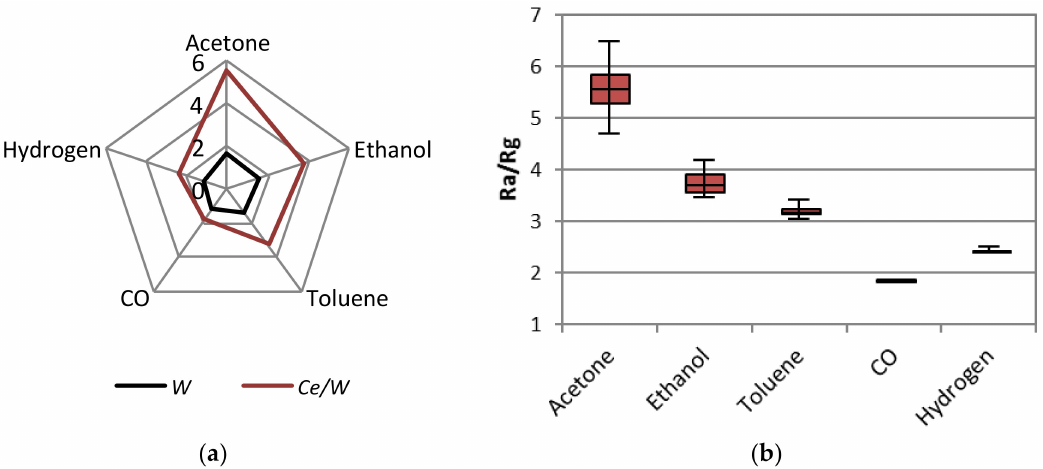
Figure 7. ( a ) The radial plot of the sensor response to 80 ppm of acetone, ethanol, toluene, carbon monoxide, and hydrogen using the W and Ce / W based sensors. ( b ) Box plots of the sensor response to each analyte recorded by the Ce / W based sensors. Each box displays the median and upper and lower quartiles (first and third) of the respective distribution. Box whiskers indicate the dispersion of the measurements.